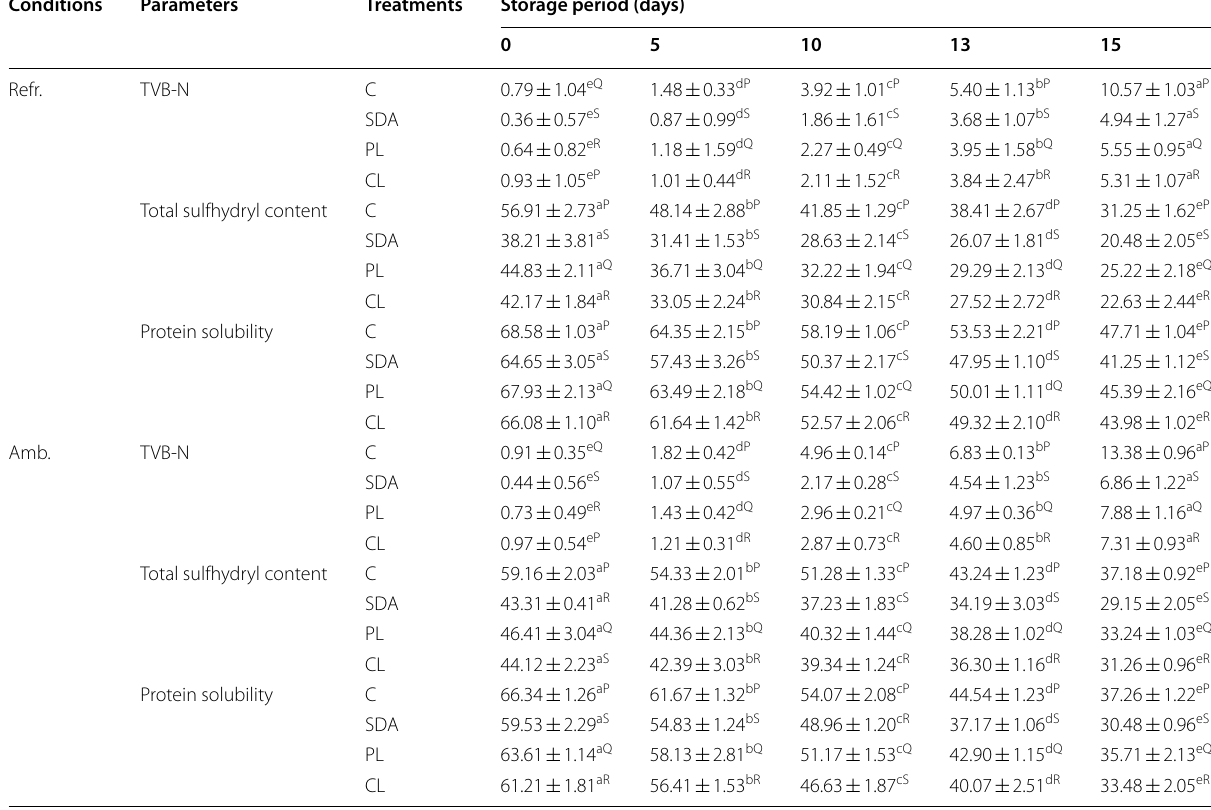
All values are mean standard deviation of three replicates ( n ± Values followed by same letter in a row and in the column do not differ significantly ( p within a column C: control; SDA: gravy treated with 0.25% sodium diacetate; PL: gravy treated with 2.5% potassium lactate; CL: gravy treated with 2.5% calcium